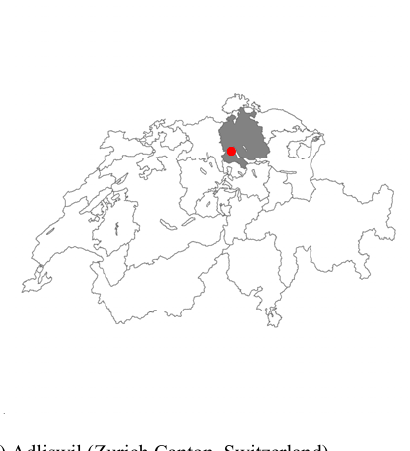
Figure 2. Case study location and area aerial